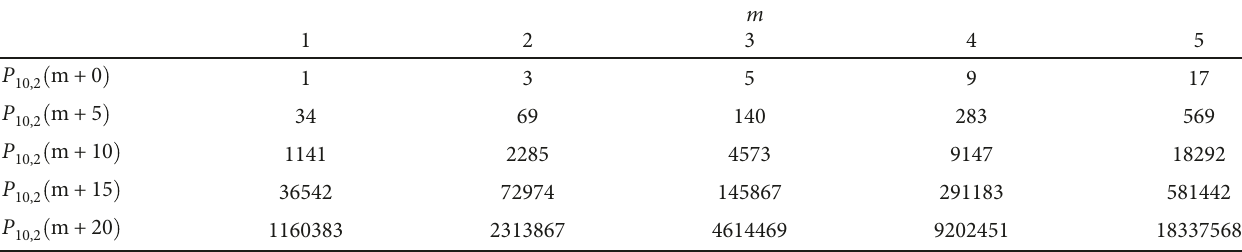
n sequence for n ≤ 25 10,2